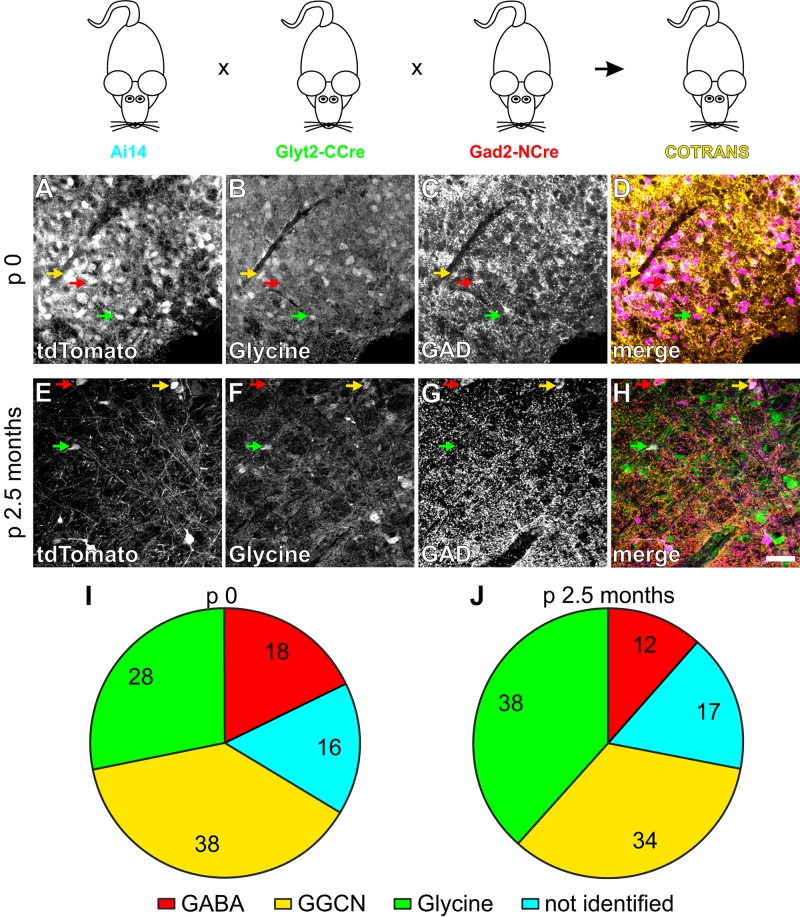
Fate mapping of individual GGCN using COTRANS mice. In COTRANS mice, GGCN, which have a GABA and glycine cotransmitting phenotype will be irreversibly labeled by tdTomato expression. Examples of fate identification at p0 (A–D) and 2.5 months (E–H), by labeling tdTomato positive cells (A,E) for glycine (B,F) or GAD (C,G). (D,H) Overlay with tdTomato in purple, glycine in green and GAD in red. Examples of GGCN neurons are marked with a yellow arrow. Scale bar in (H) corresponds to 50 μm and applies to (A–H). Quantification of the cell populations at p0 (I) and 2.5 months (J). Pie charts show the mean values of n = 3 and 8 mice for p0 and 2.5 months, respectively. In total, 1133 and 1109 cells were counted for p0 and 2.5 months of age, respectively. 100% corresponds to all cells labeled by tdTomato expression. See Supplementary Figure 4 for the distribution of data.